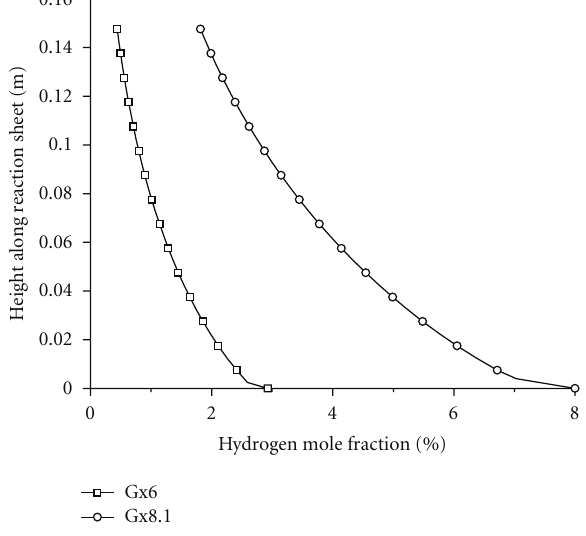
Figure 13: Steady-state average hydrogen concentration in recom- biner for Gx test series.